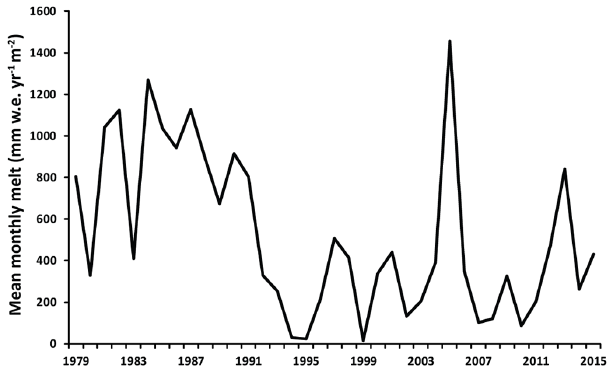
Figure 10. Mean RACMO2.3-derived December melt 1979–2015 in Porpoise